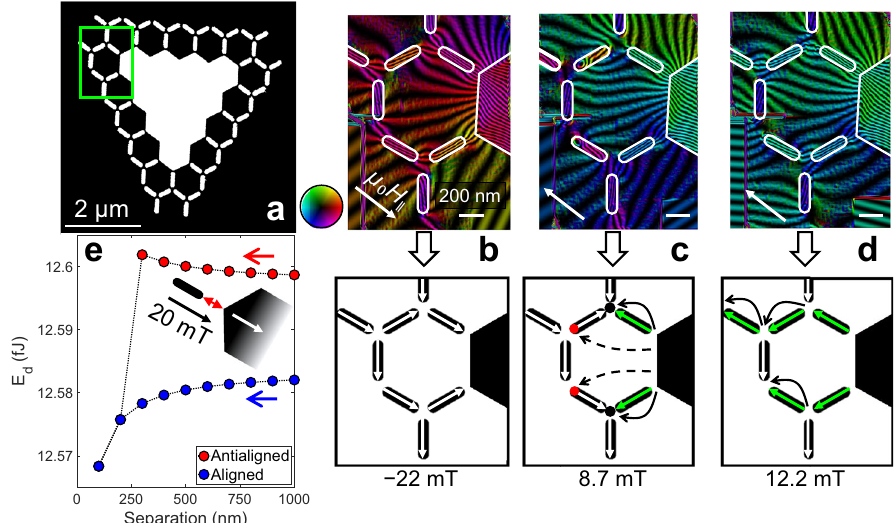
Fig. 2 Visualization of fl ux-coupling in DASI. a Schematic of a smaller DASI lattice with analyzed region represented by green rectangle. b – d electron holograph reconstructed phase contour images and schematics (top and bottom panels, respectively) at snapshots of fi eld reversal in DASI along the direction of the white arrow; colors and contour density represent the direction and magnitude of the magnetic fl ux, respectively, with reference to the color-wheel. Solid black arrows on schematics indicate the MP propagation direction, whereas dashed arrows indicate the long-range defect-vertex coupling that stabilizes the vortex domain walls (red dots). White and green arrows represent the initial and switched island magnetization, respectively. e Modeled demagnetization energy ( E d ) of the saturated defect and a single island initially magnetized anti-parallel (red) and parallel (blue) to the applied fi eld ( μ = 20 mT) as a function of defect-island separation. 0 H ‖